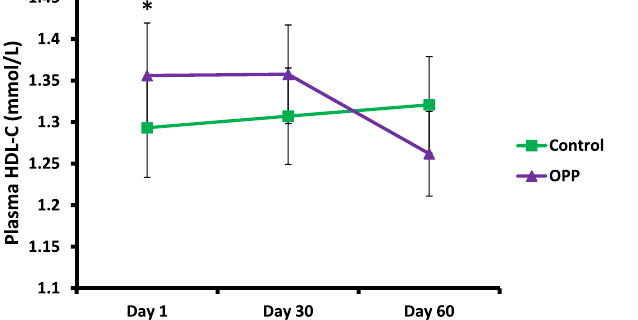
Figure 3. HDL-C level following OPP and control treatments for 60 days. * Baseline HDL-C level was significantly different between treatments, p = 0.038 (Wilcoxon’s signed-rank test). Value was further used as covariates in repeated measures. Although the time × treatment analysis was significant, p = 0.011 (2-factor repeated measures ANOVA), no significant difference of HDL-C level was found between treatments at day 30 and 60 (Wilcoxon signed rank test). Similarly, no significant difference of HDL-C level was found between treatments at day 30 and 60 after Bonferroni